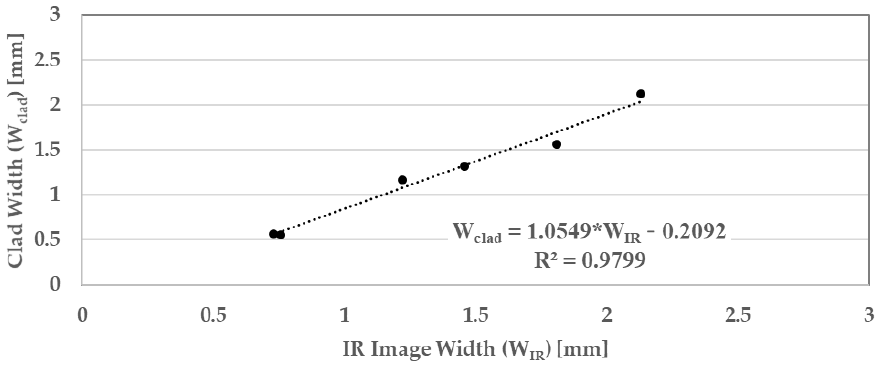
Figure 11. Correlation between IR image width (molten pool’s width) and clad width from experiment.